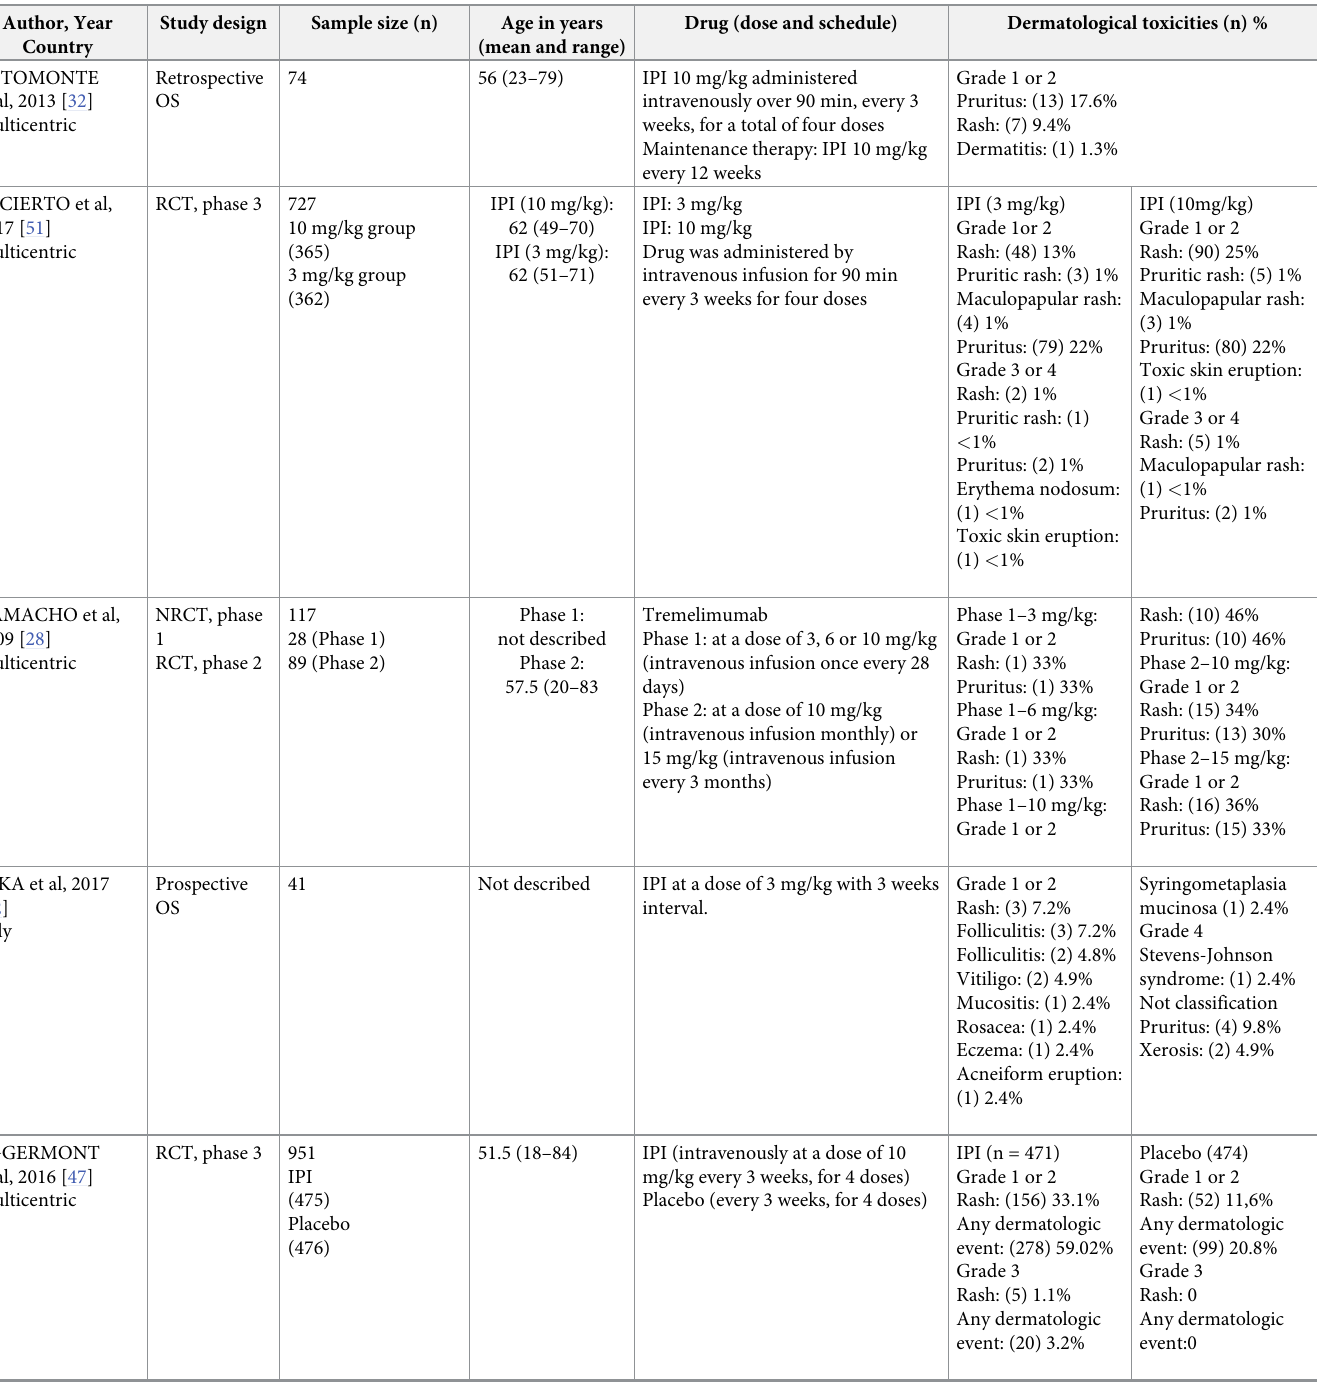
Table 1. Studies included in the review according to methodological characteristics (n =